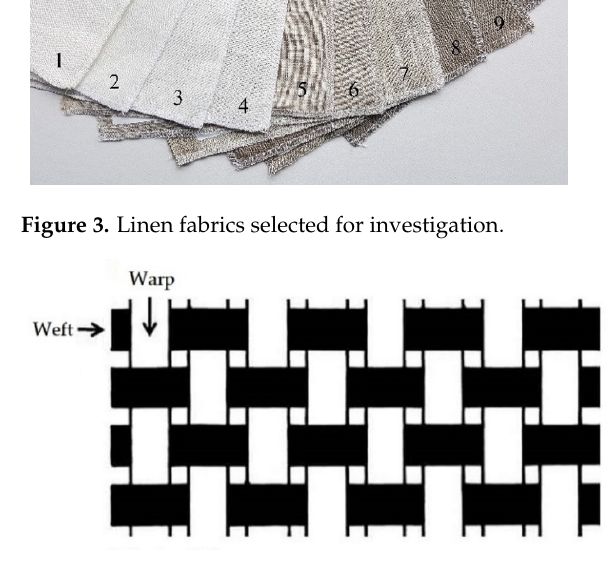
Figure 4. Woven fabric structure characteristics.